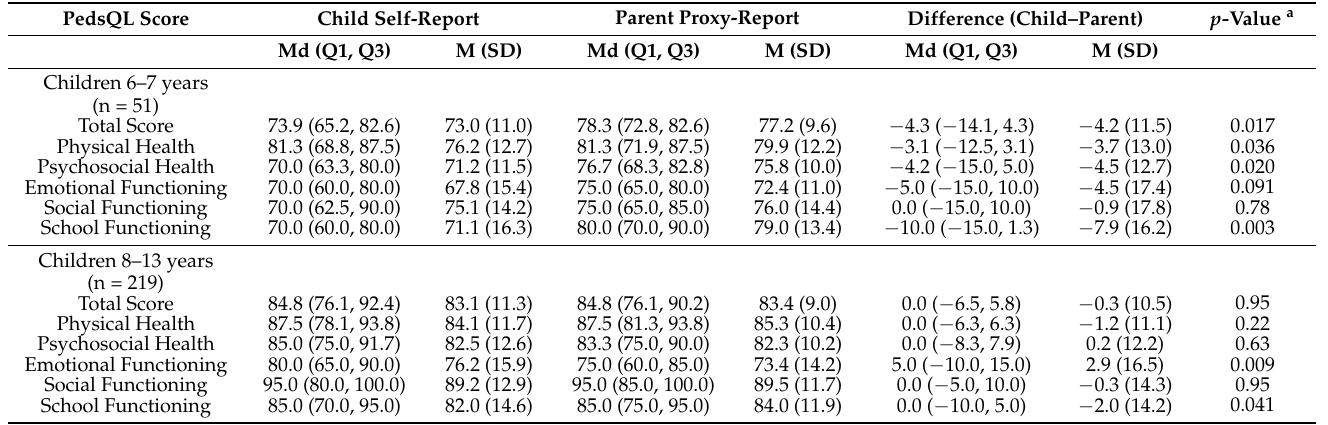
Table 2. Children’s and parental proxy-report of